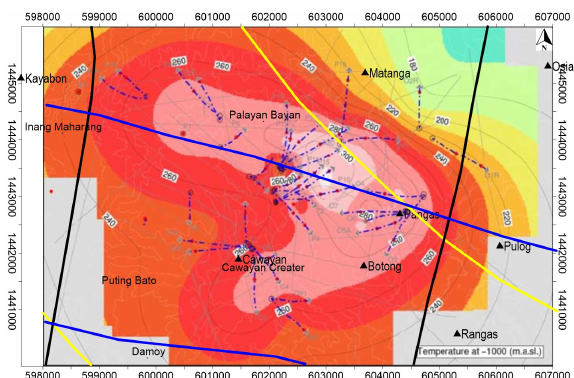
Fig. 4. An isoresistivity map at a depth of -1100 m from MSL which is correlated with the geological structure in the area, shows that the central part of the Bac-Man fault zone has a low resistivity value